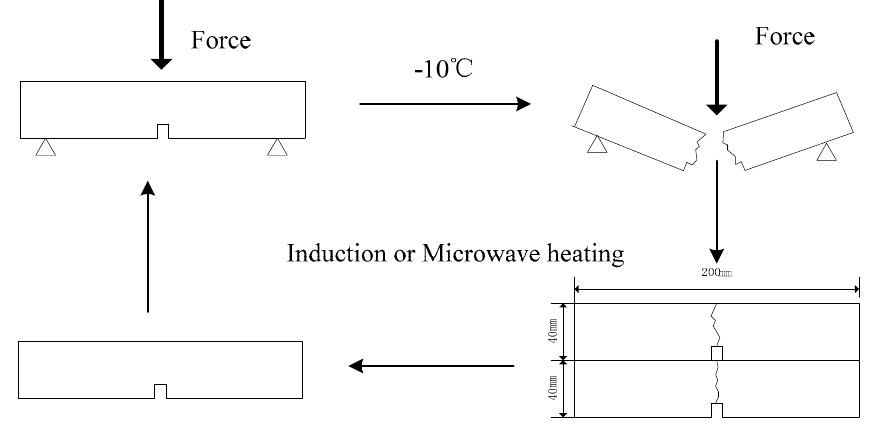
Figure 3. Healing test procedure of beam samples.